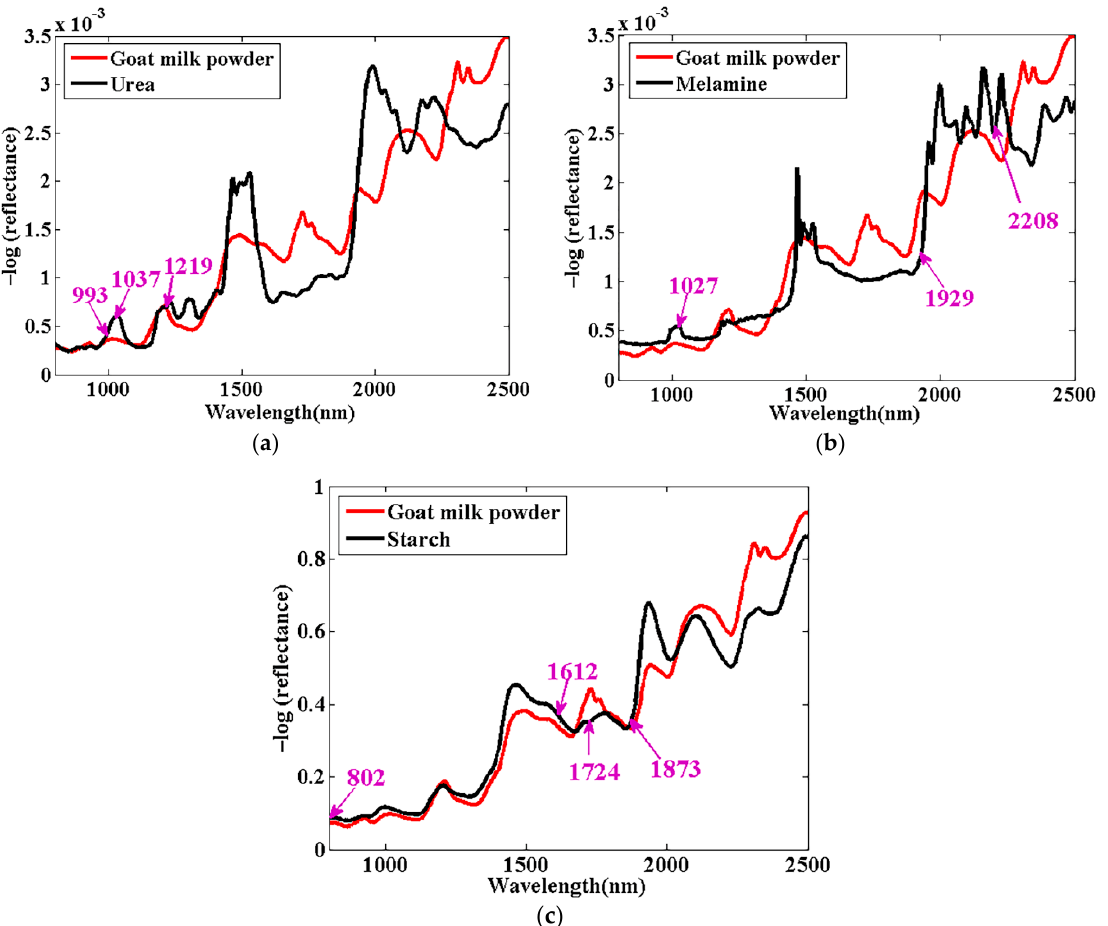
Figure 5. Average spectra of goat milk powder and the three adulterants (urea ( a ), melamine ( b ), and starch ( c )) after the application of optimal pretreatments with the flagged characteristic wavelengths.